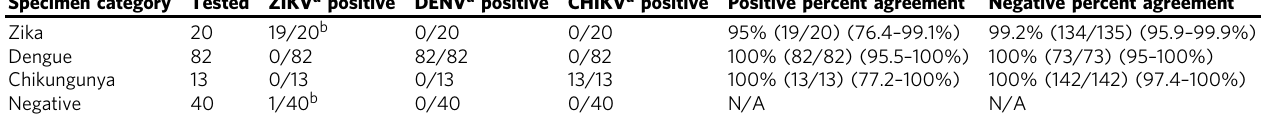
Table 2 Performance of Trioplex with archived clinical serum